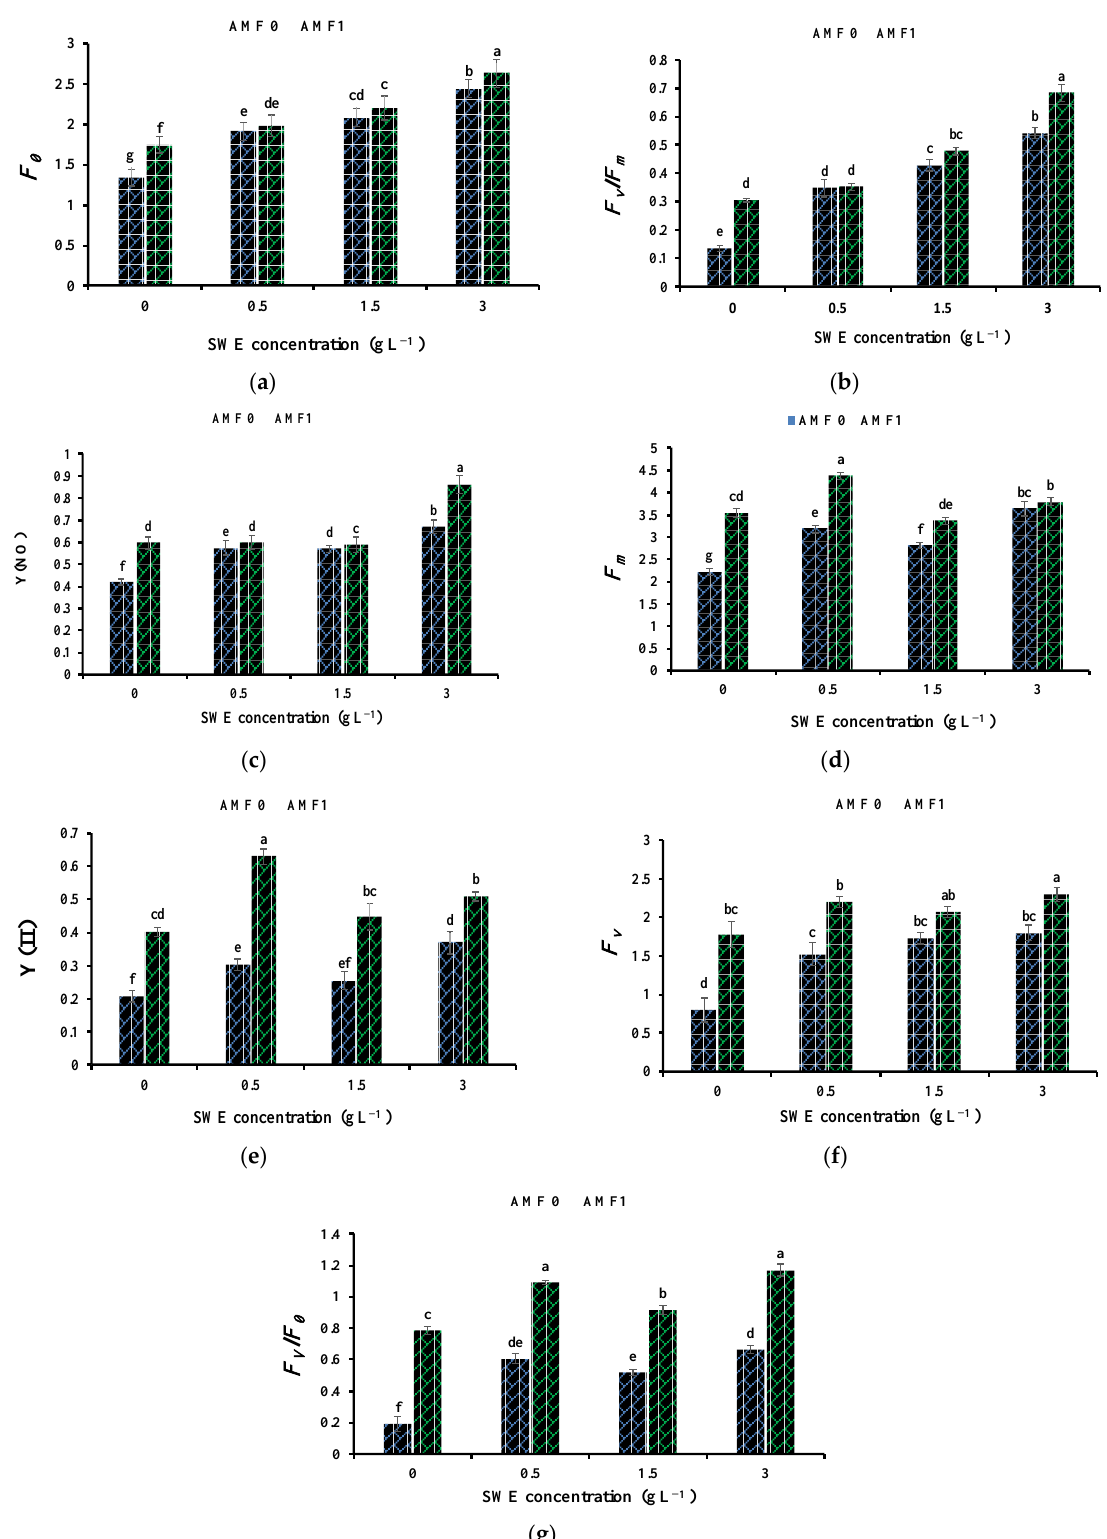
Figure 2. Effect of AMF inoculation (AMF 0 and AMF 1: without/with AMF, respectively) and seaweed extract (SWE) co-treatments on lettuce plants: ( a ) initial fluorescence ( F 0 ); ( b ) photochemical efficiency of PSII ( F V / F m ); ( c ) Y(NO); ( d ) maximum fluorescence ( F m ); ( e ) Y(II); ( f ) variable fluores- cence ( F V ); ( g ) electron donor photosystem II ( F V / F 0 ). Error bars represent standard deviations (SD). Different letters indicate significant differences according to the LSD test at p < 0.05.